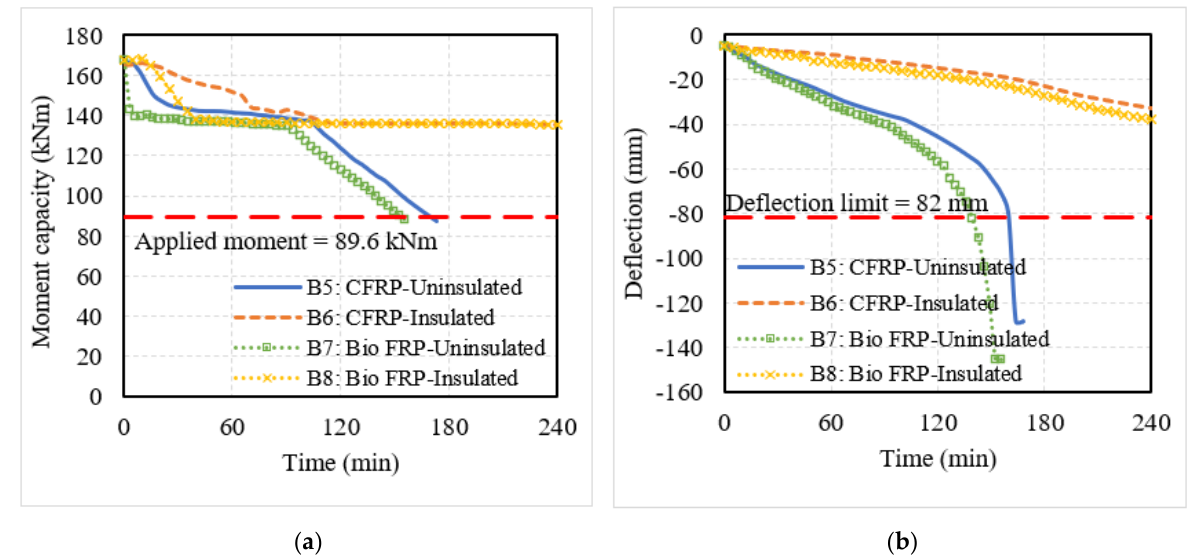
Figure 10. Structural response of T-beams strengthened with EB FRP reinforcement. ( a ) Moment capacity; ( b ) mid-span deflection.